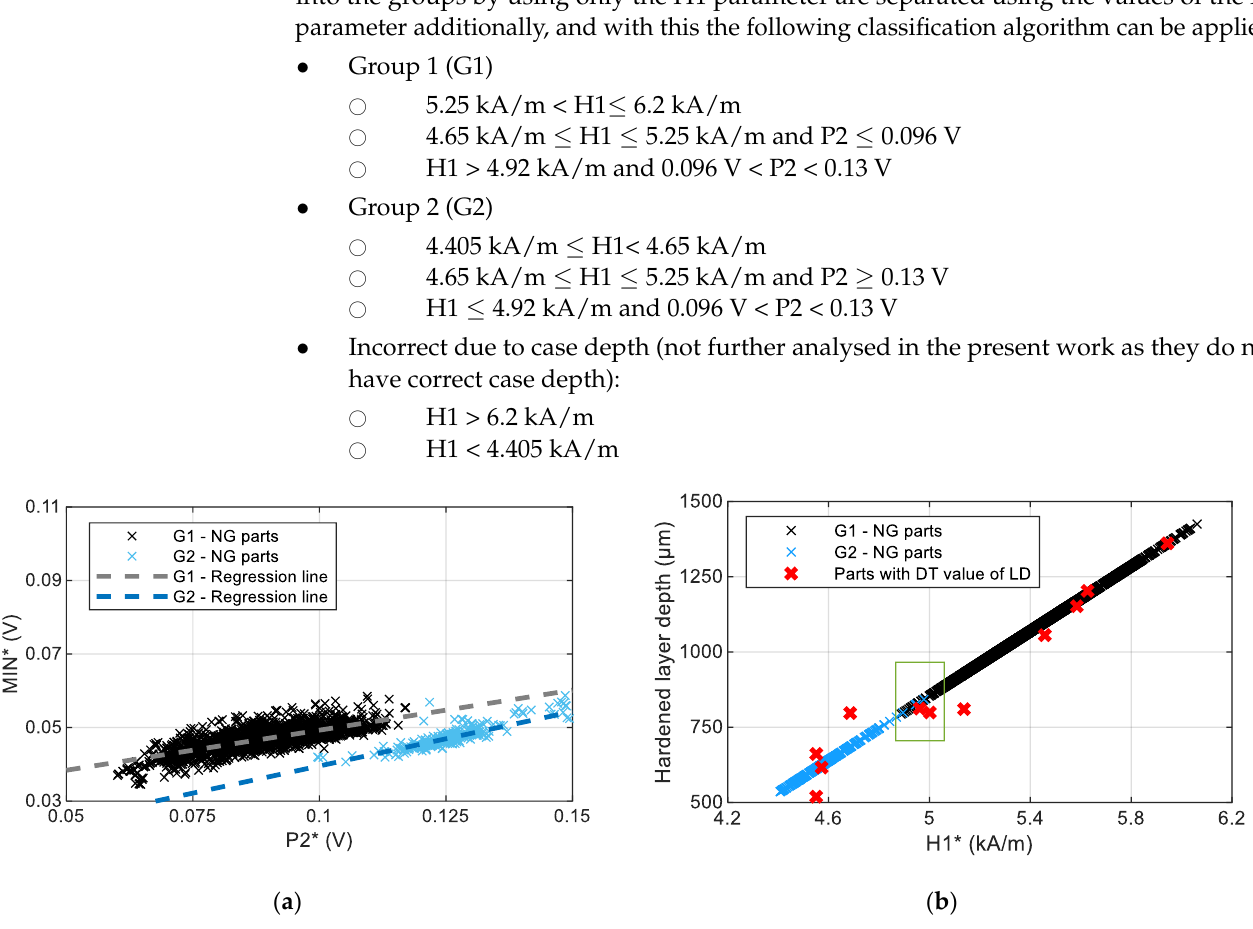
Figure 10. ( a ) The mean value of parameter MIN obtained throughout the effective length of the ball screw shaft thread as a function of the mean value of P2 and ( b ) hardened layer depth (LD) as a function of the mean value of parameter H1 obtained throughout the effective length of the ball screw shaft thread (H1*). LDs shown in blue and black markers are the estimated LDs using the linear model from [17] and LDs shown with red markers are the LD measured destructively in ball screws from [17]). The standard deviation of MIN* is 0.6 mV, of P2* is 1.6 mV and of H1* is 112 A/m.